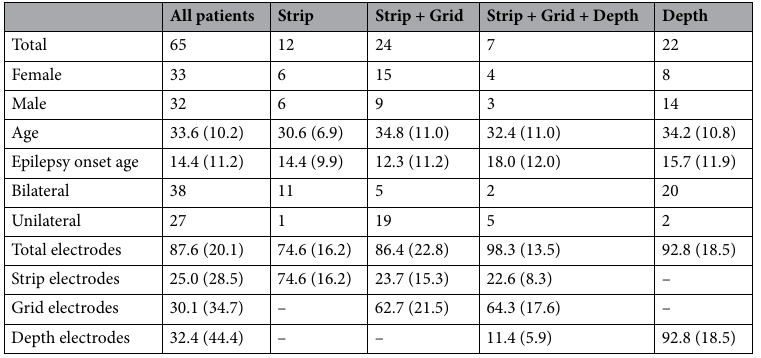
Table 1. Overview of patient characteristics and the use of strip, grid, and depth electrodes. Ages and electrode counts are reported as mean (standard